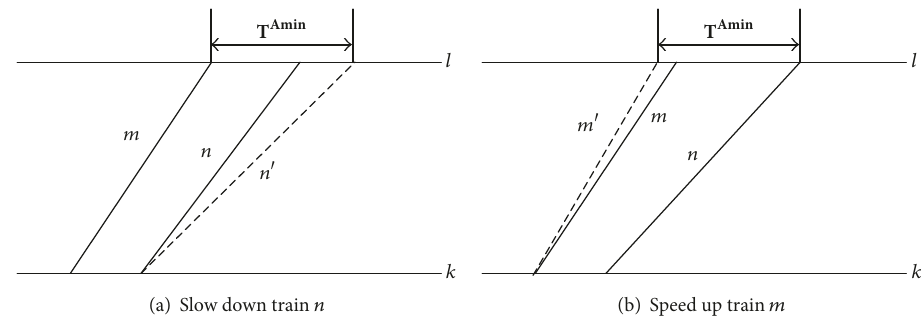
Figure 4: Arrival time conflict and